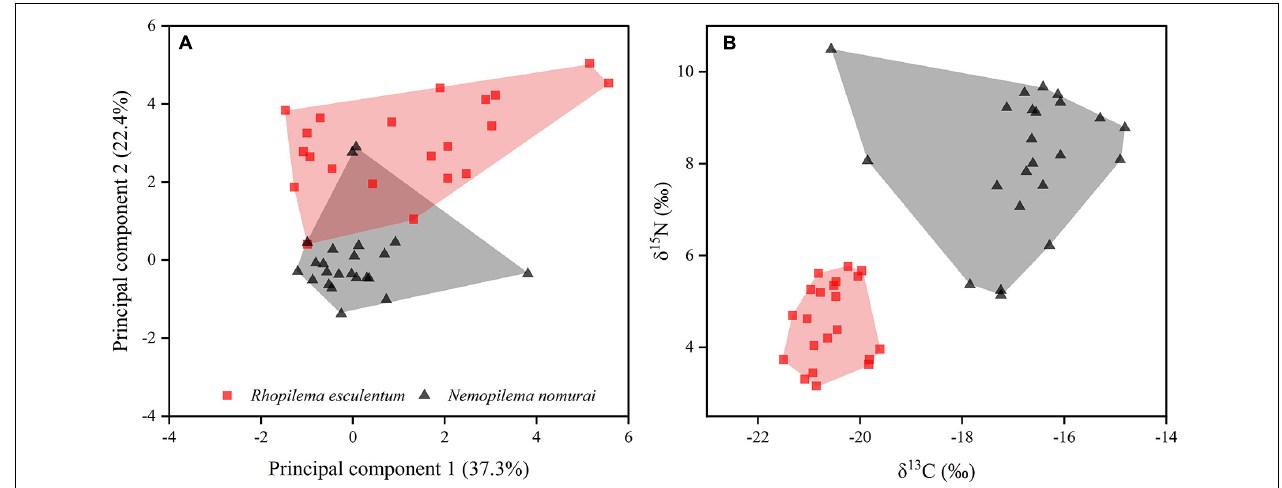
FIGURE 4 | Principal component analysis of fatty acid profiles (A) and stable isotopic ratios (B) of sympatric Rhopilema esculentum and Nemopilema nomurai collected from Yangtze Estuary.